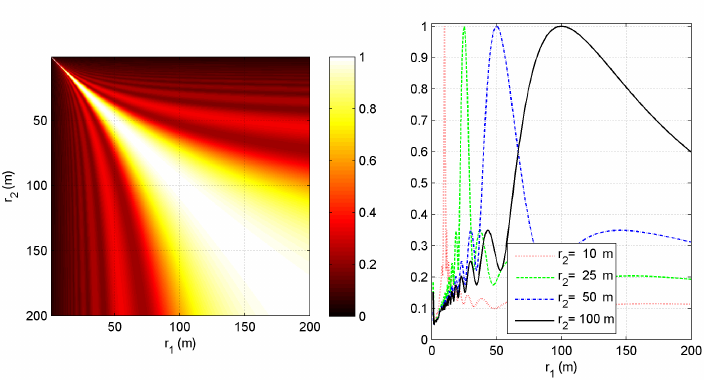
Figure 11. Two terminal correlation analysis for the 2 λ non-equispaced array with α 1 = − 0.03. ( Left ) Image map with the correlation level for variable r 1 and r 2 ; ( Right ) plot of the correlation coefficient for some fixed values of r 2 .